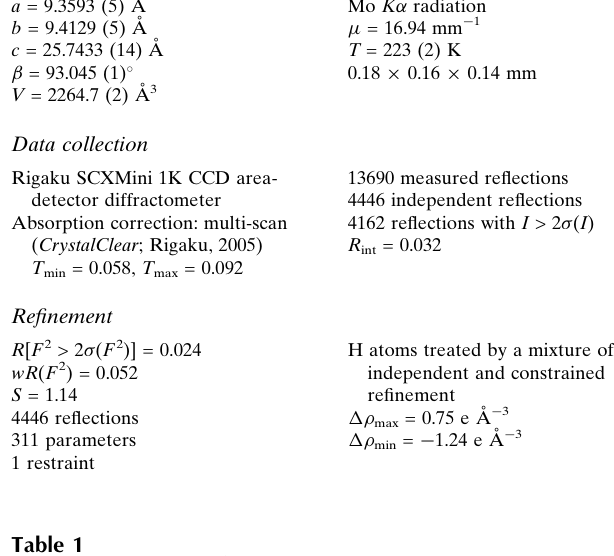
Selected bond lengths (A˚